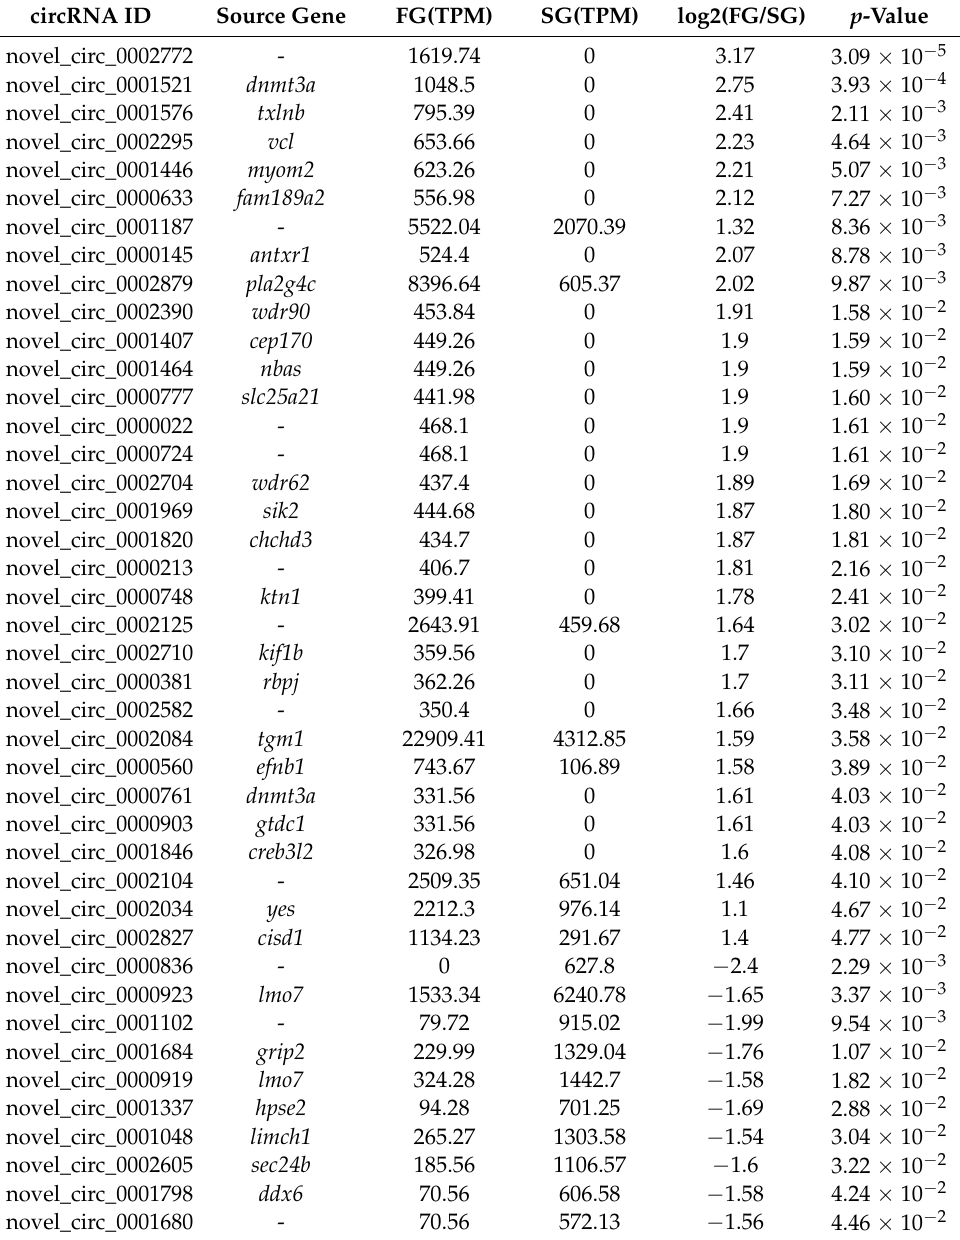
Table 2. The DE circRNAs between FG and SG groups of M. amblycephala